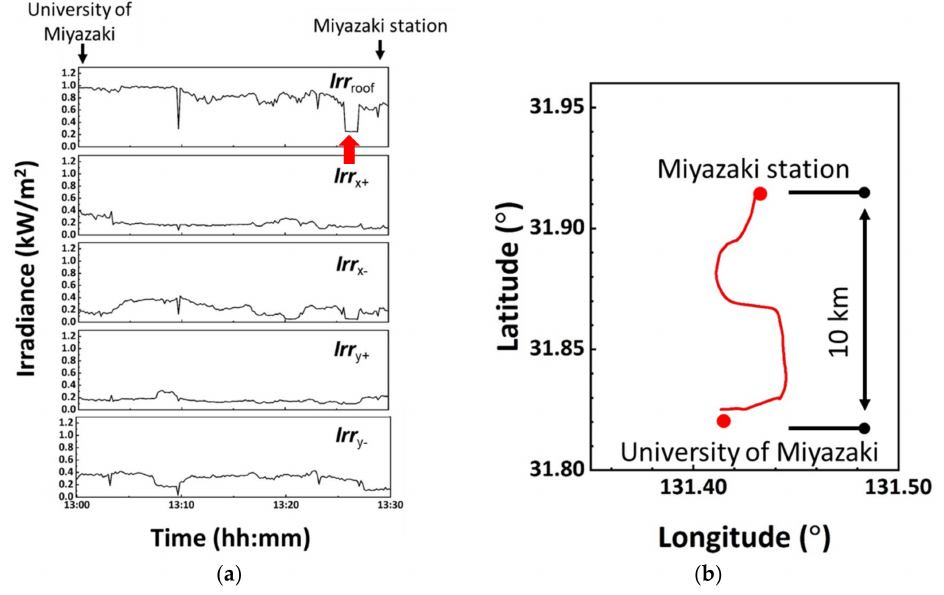
Figure 4. ( a ) Irr x + , Irr x − , Irr y + , Irr y − , and Irr roof measured by the MMPA system. In this case, the car with the MMPA system traveled from the University of Miyazaki to the Miyazaki station; ( b ) The route from the University of Miyazaki to the Miyazaki station. The actual distance traveled was approximately 15 km. Table 2. Average daily irradiances of the car’s roof, its side, and its front and rear. The measurement period was from September 2017 to August 2018. The average daily irradiance of the horizontal surface is also